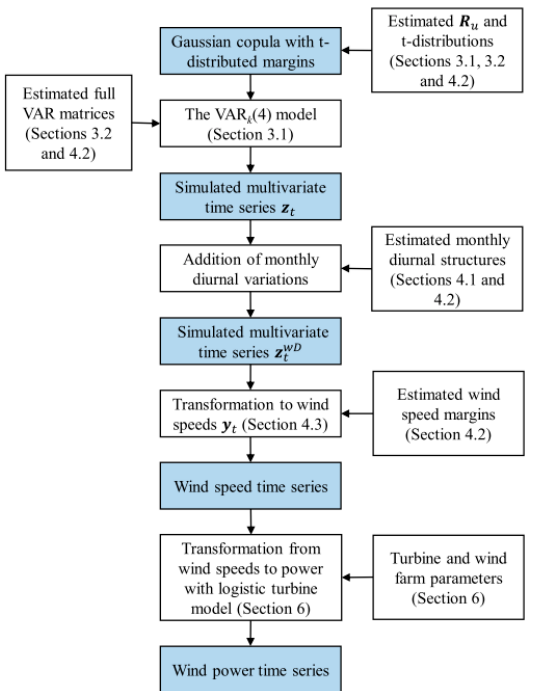
Figure 2. A flowchart of the MC simulation procedure to simulate wind power generation in non-measured WPP locations. White background indicates operations and blue indicates simulated data.